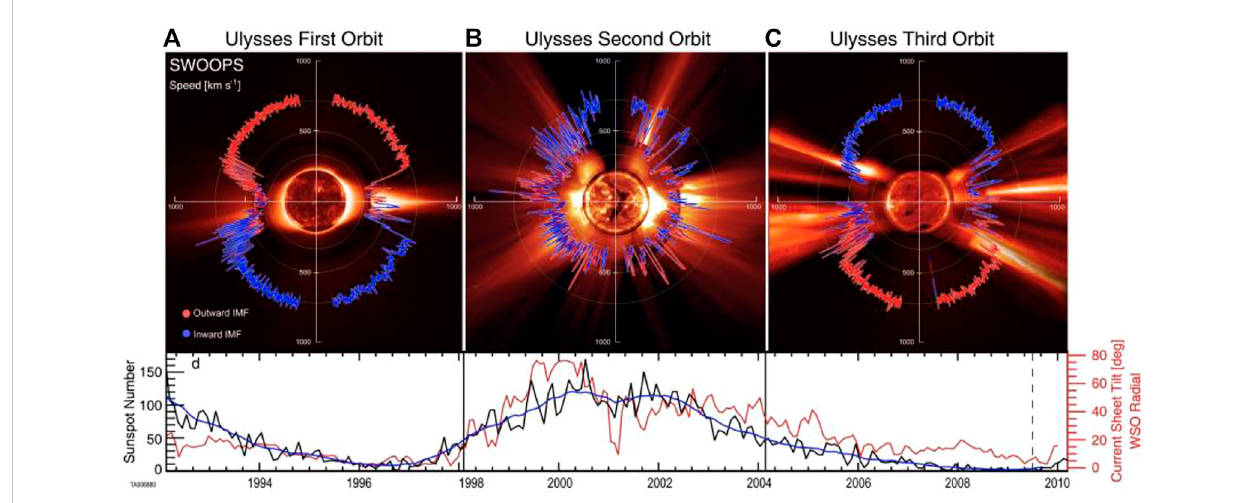
FIGURE 2 The latitudinal solar wind speed distribution: from the left during the minimum solar activity. (A) is same as Figure 1, (B) a high activity and (C) a weak activity; the Figure shows also the sunspot number and inclination of the heliospheric current sheet (McComas et al., 2013).